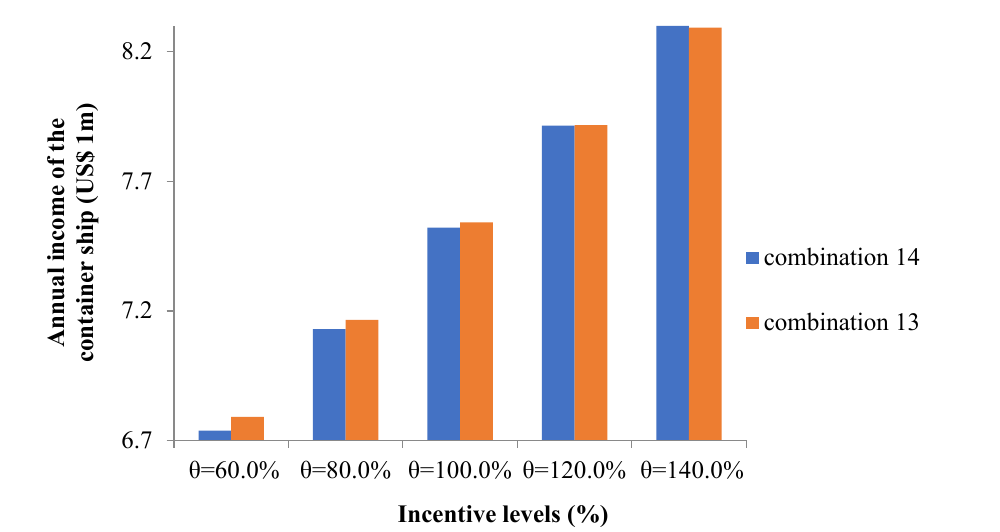
Figure 6. Annual net income for combination 13 and combination 14 when incentive levels rise.